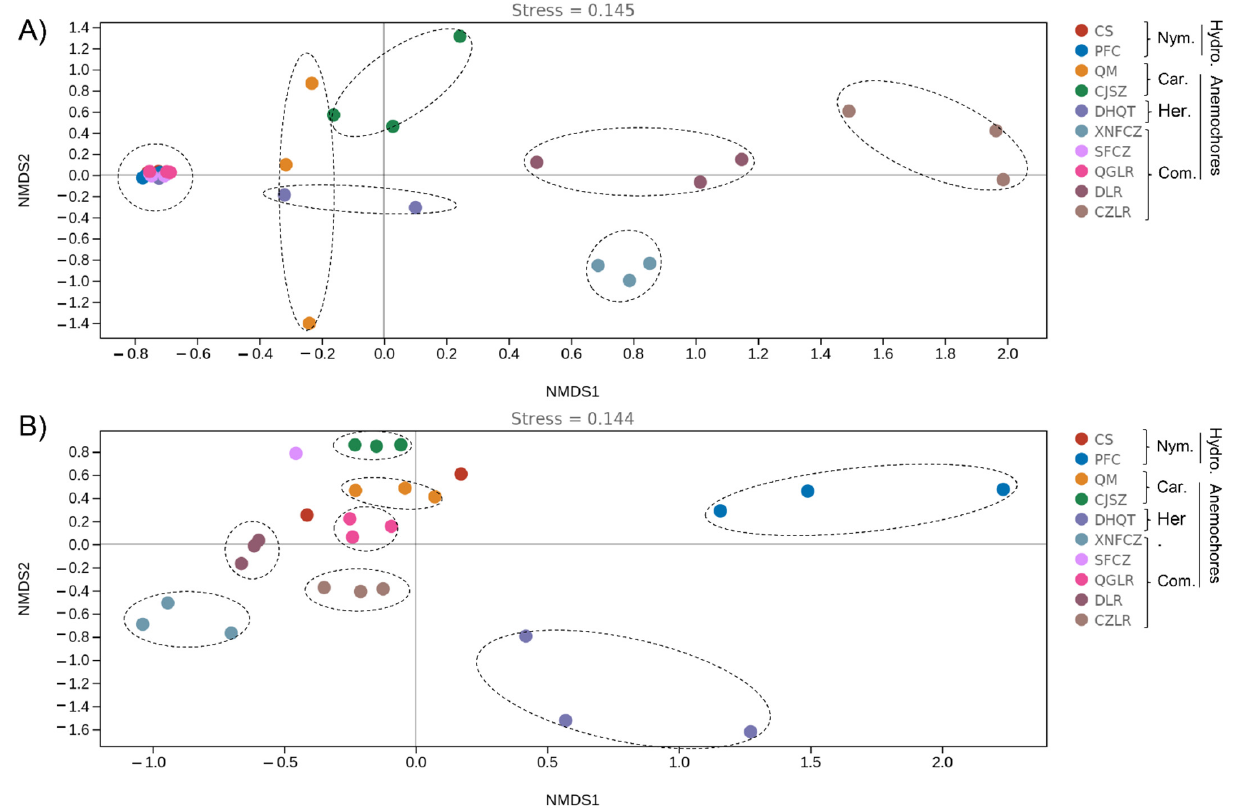
Figure 3. Seed endophytic bacterial ( A ) and fungal ( B ) community compositions as indicated by non-metric multidimensional scaling plots (NMDS) of pairwise Bray–Curtis distance in the eight anemochores and two hydrochores. The abbreviations behind the bracket indicate plant family name (Car, Caryophyllaceae; Com, Combretaceae; Her, Hernandiaceae; Nym, Nymphaeaceae) and their assigned dispersal mode (hydrochores/anemochores), including two hydrochoric herbs (CS, Euryale ferox ; PFC, Nuphar pumila ), two anemochoric herbs (QM, Dianthus superbus ; CJSZ, Dianthus repens ), three anemochoric vines (DHQT, Illigera grandiflora ; XNFCZ, Combretum griffithii ; SFCZ, Combretum wallichii ), and three tree species (QGLR, Terminalia myriocarpa ; DLR, Terminalia franchetii ; CZLR, Terminalia franchetii ).